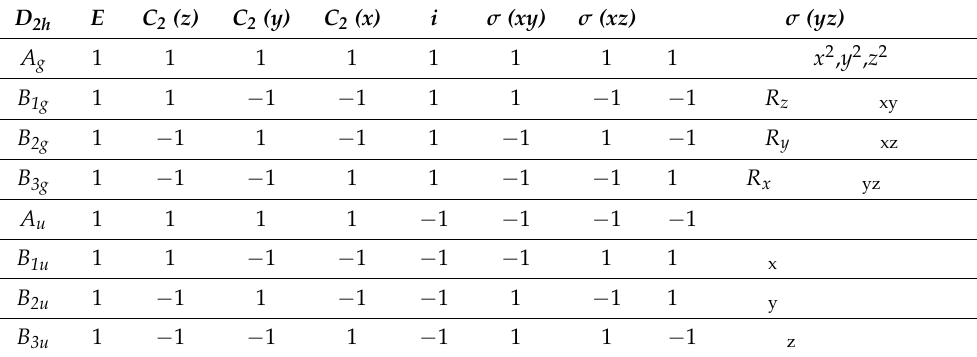
Table 1. D 2h Group.